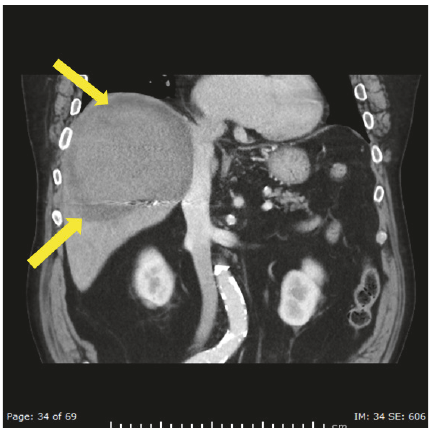
Figure 6: Coronal plane CT of the abdomen after embolization with administration of intravenous contrast in portal phase done 1 week after the embolization, demonstrating the collection with no active extravasation. There is a peripheral rim of low attenuation likely related to infracted hepatic parenchyma (yellow